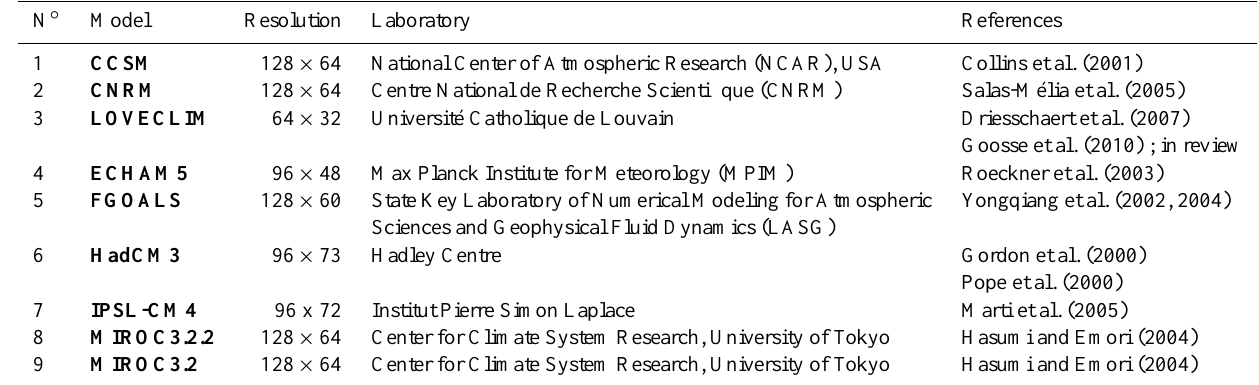
Table 1. PMIP2 models references (resolutions are in LON ×